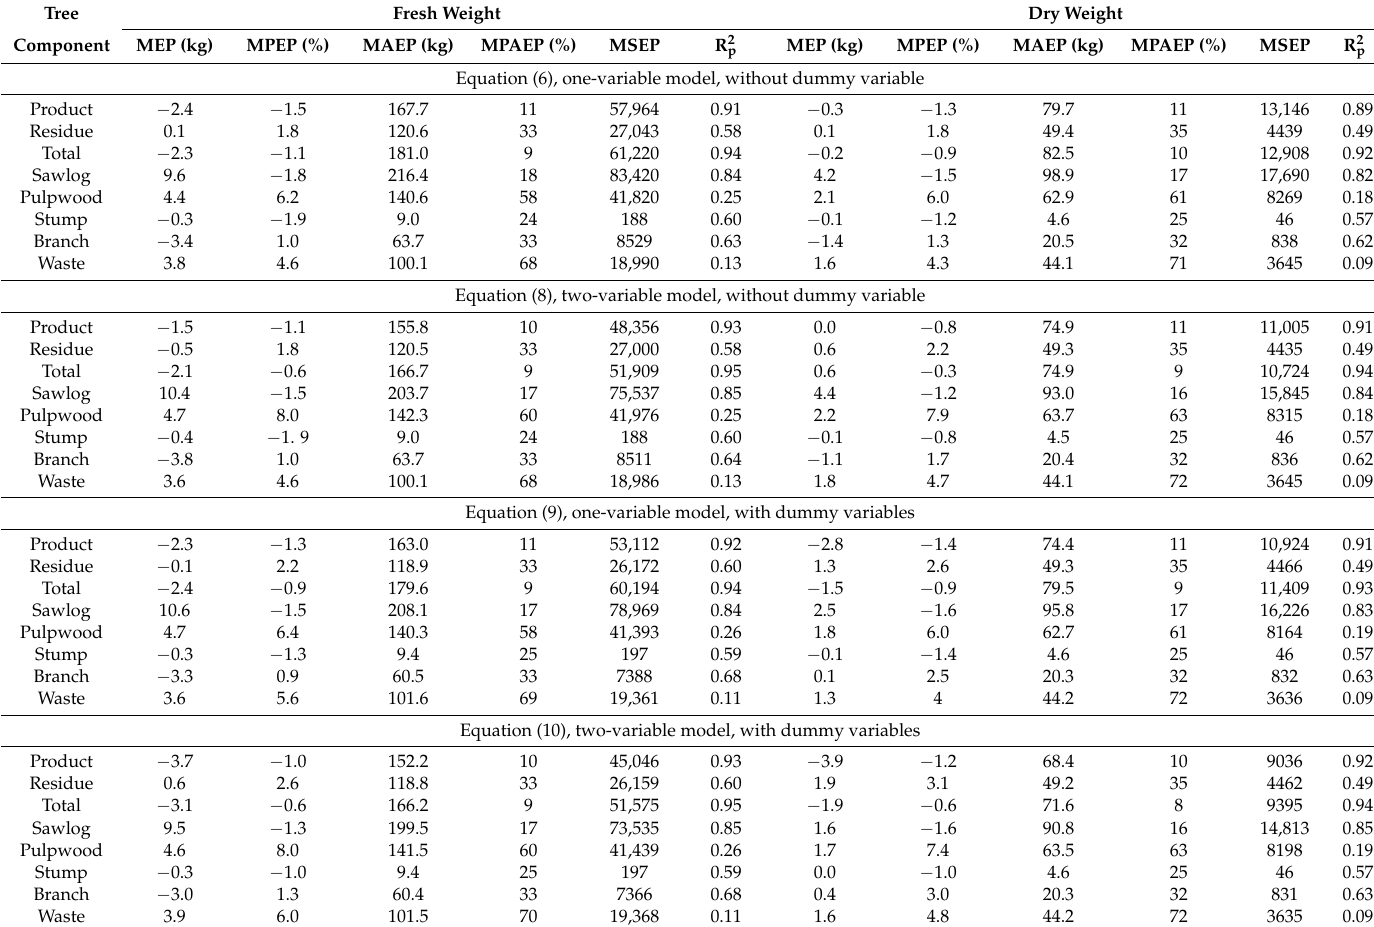
Table 10. Benchmarking statistics for component and total tree fresh and dry weight predictions calculated following the leave-one-plot-out cross-validation procedure: the mean error of prediction (MEP), the mean percentage error of prediction (MPEP), the mean absolute error of prediction (MAEP), the mean percentage absolute error of prediction (MPAEP) and the mean squared error of prediction